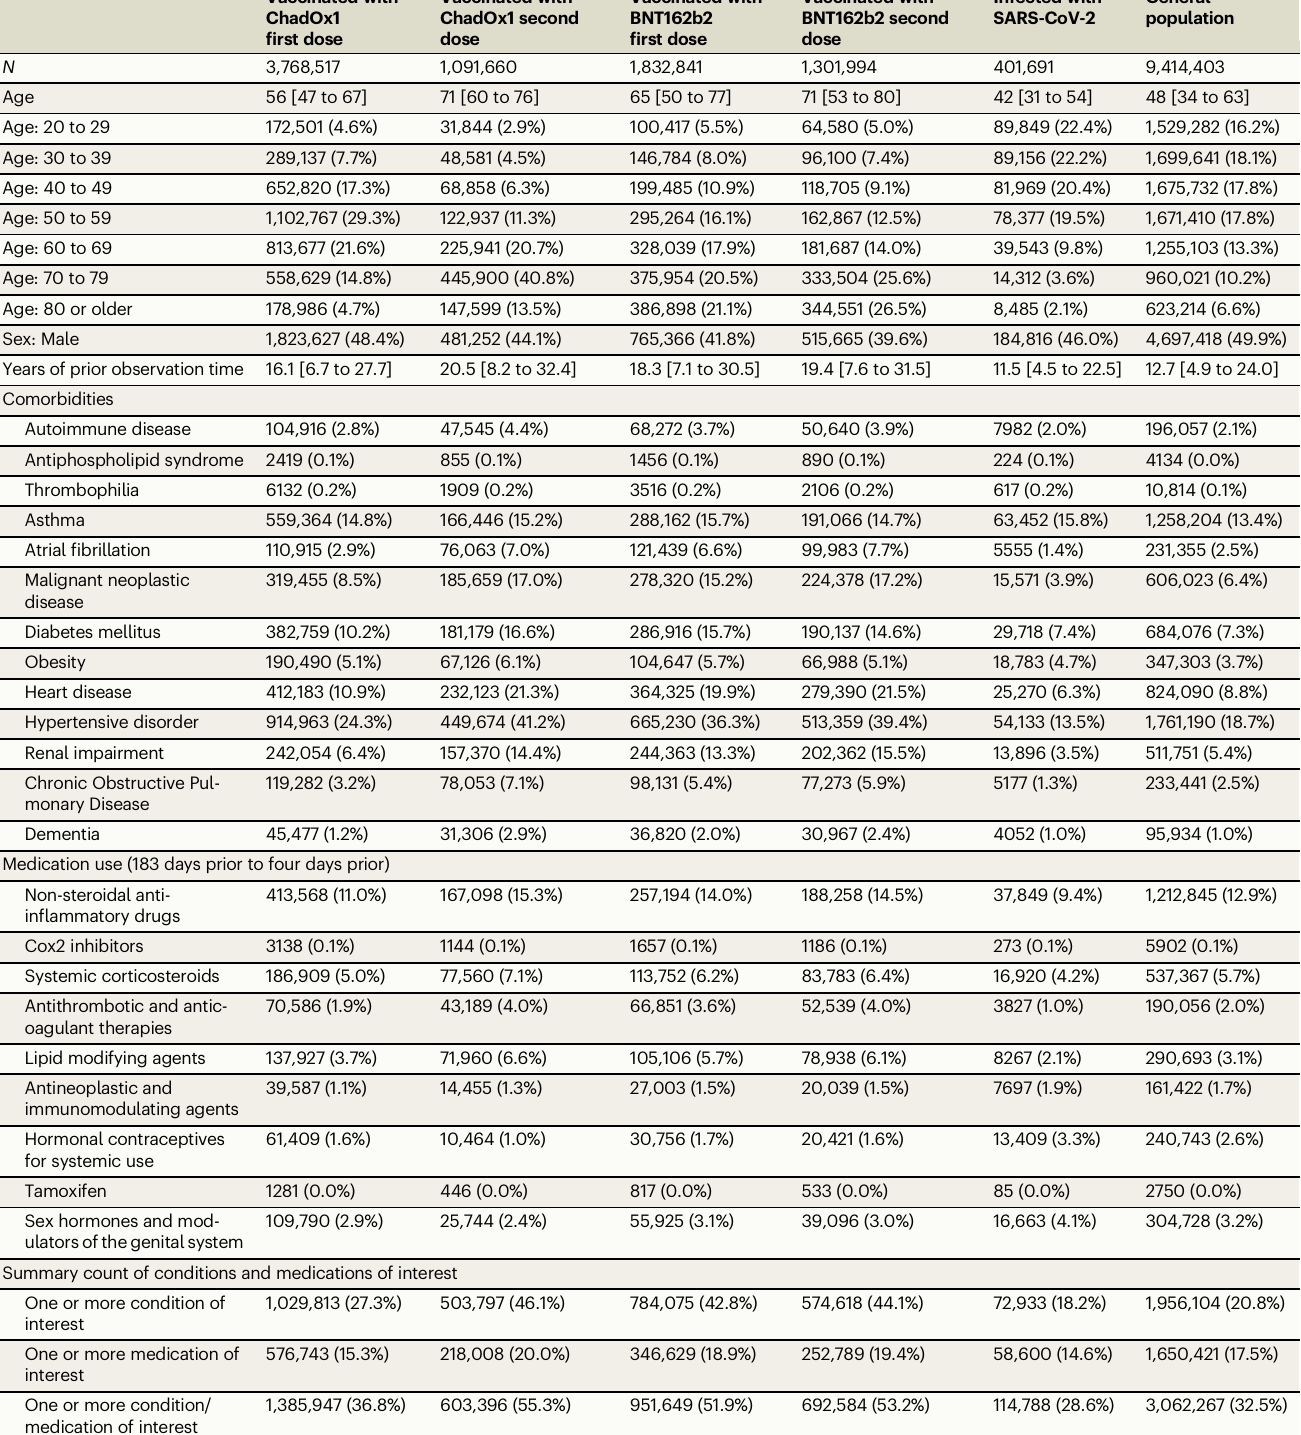
Table 1 | Characteristics of study